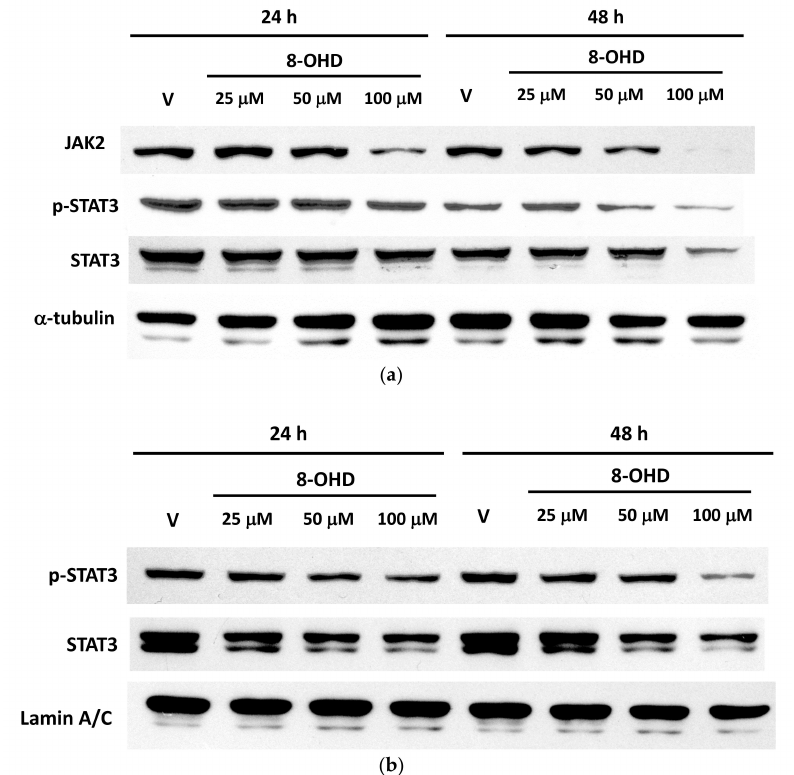
Figure 3. Western blot analysis of the Janus kinase (JAK)/signal transducer and activator of transcrip- tion 3 (STAT3) signaling pathway in 8-OHD-treated K562 cells. ( a ) Cell lysates were prepared